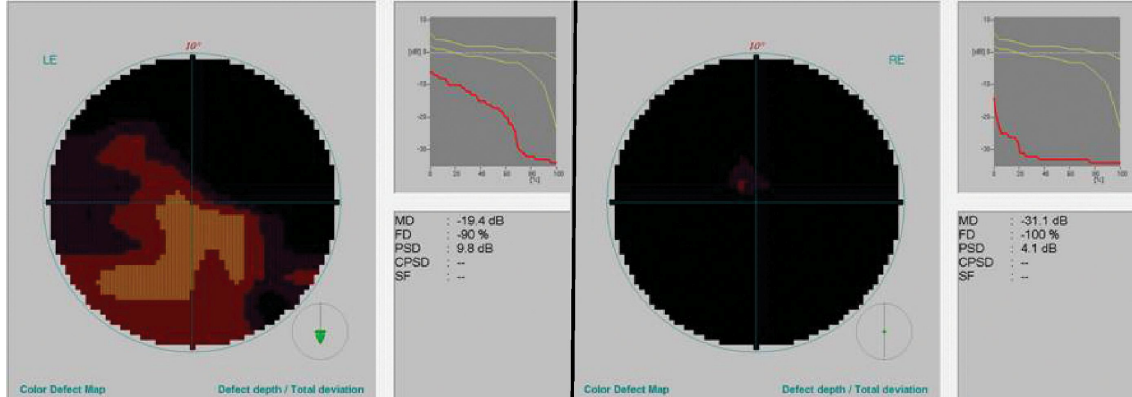
Figure 3: Eleven days after surgery, automated perimetry revealed a marked improvement in the left eye (RE: right eye, LE: left